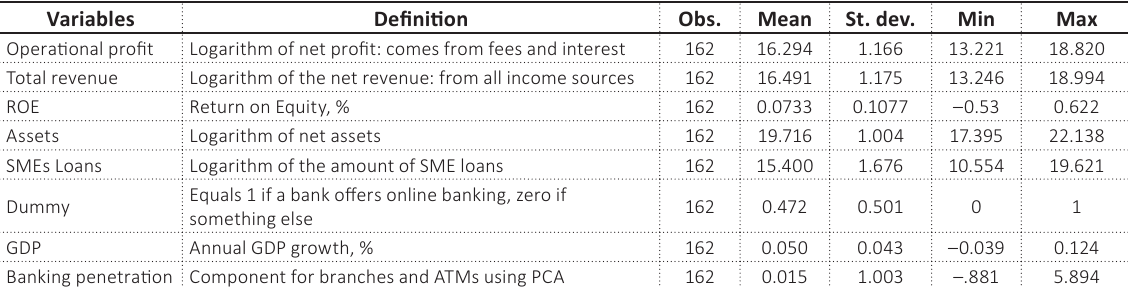
Table 2. Variable definitions and descriptive statistics